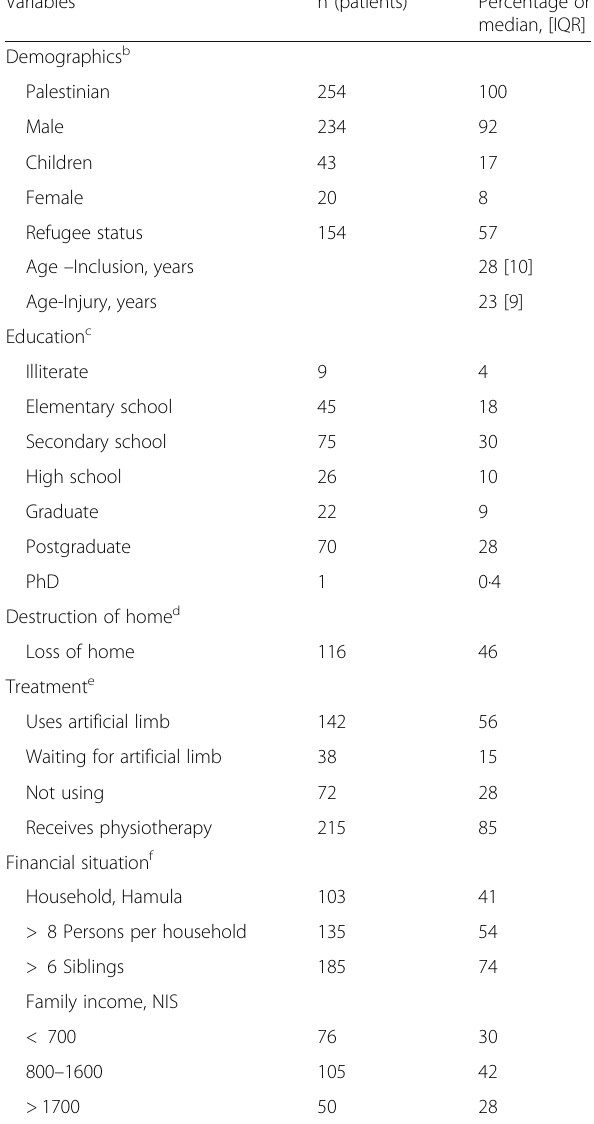
Table 1 Characteristics of study participants a ( N = 254)